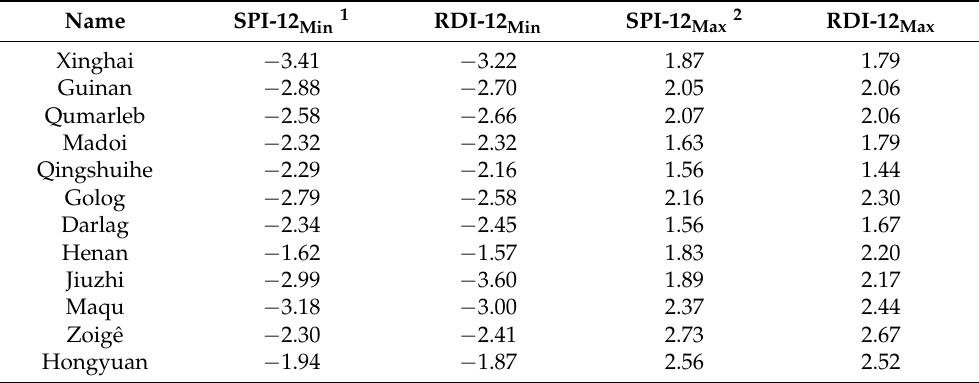
Table 3. Comparison of SPI and RDI at each meteorological station on annual